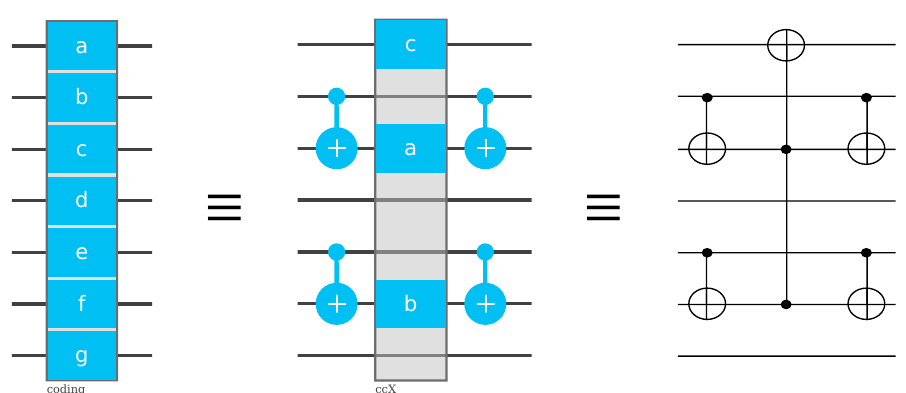
Figure 6. The “coding” subroutine. Letters in the blue blocks denote the different qubits in this multi-qubit operation , where a is the qubit for color information, | G (cid:105) ; the position qubits | Y (cid:105) and | X (cid:105) consist of bcd and efg (note that the letters in a specific operation are irrelevant between different operations, they only distinguish different qubits within the operations). The diagram in the middle shows the composition in quantum IBM Q experience, and the counterpart in the quantum circuit notation is shown on the right.